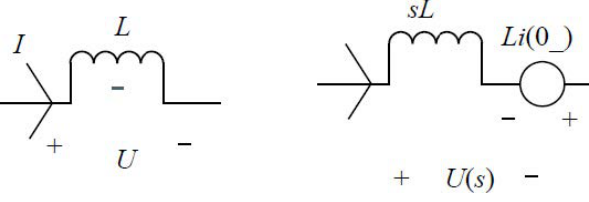
Fig. 3 Inductance